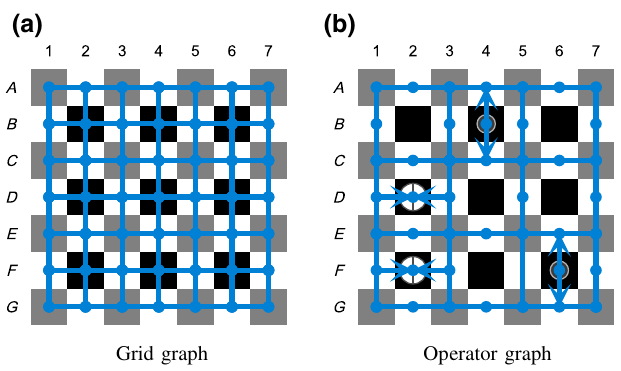
FIG. 7. The graphs used in this paper. (a) The grid graph where each surface code patch corresponds to a vertex and is connected to its neighbors. (b) The operator graph for a set of terminal pairs T that correspond with a parallel T CNOT circuit. EDP sets for on this graph are also operator EDP